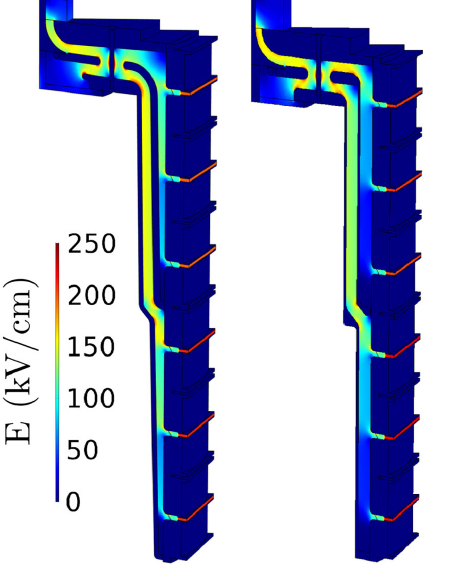
9. Electric field strength computed by COMSOL for the conical (left) and straight (right) transmission lines. The view is the same as the view in Fig.